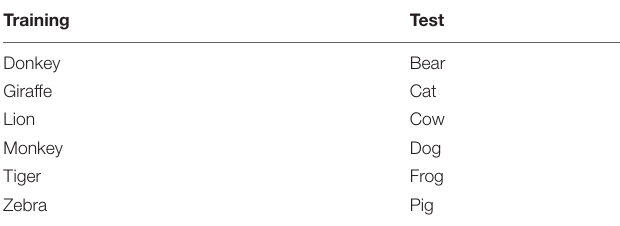
TABLE A1 | Nouns used in training vs. test